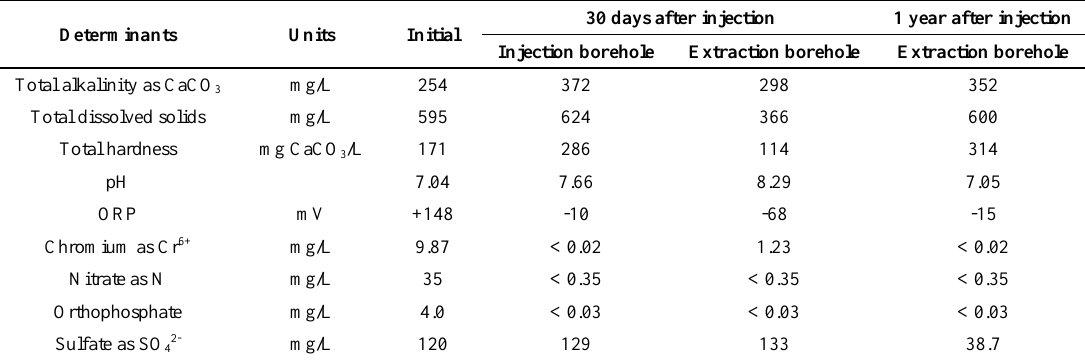
Table 3. Geochemical dataset of inorganic parameters during in situ treatment for site A